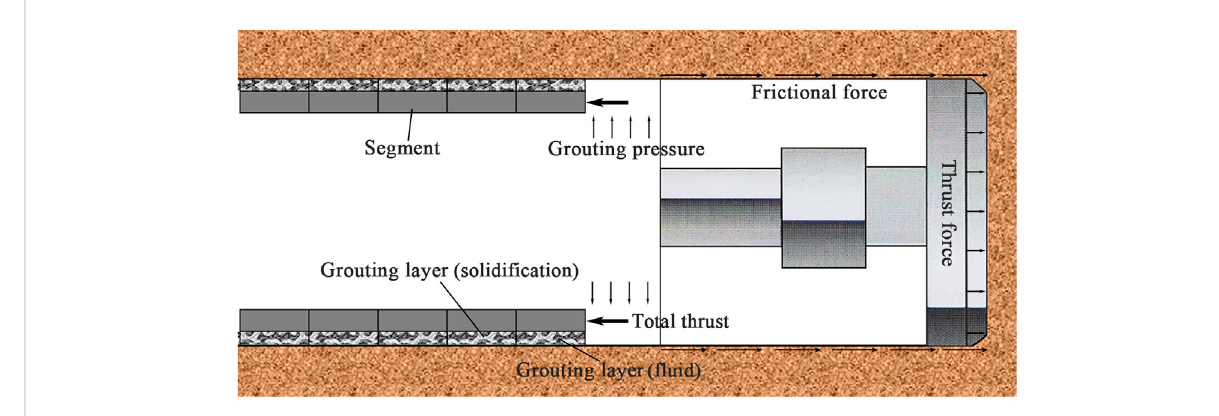
FIGURE 6 Simulation process of the TBM tunnel construction.